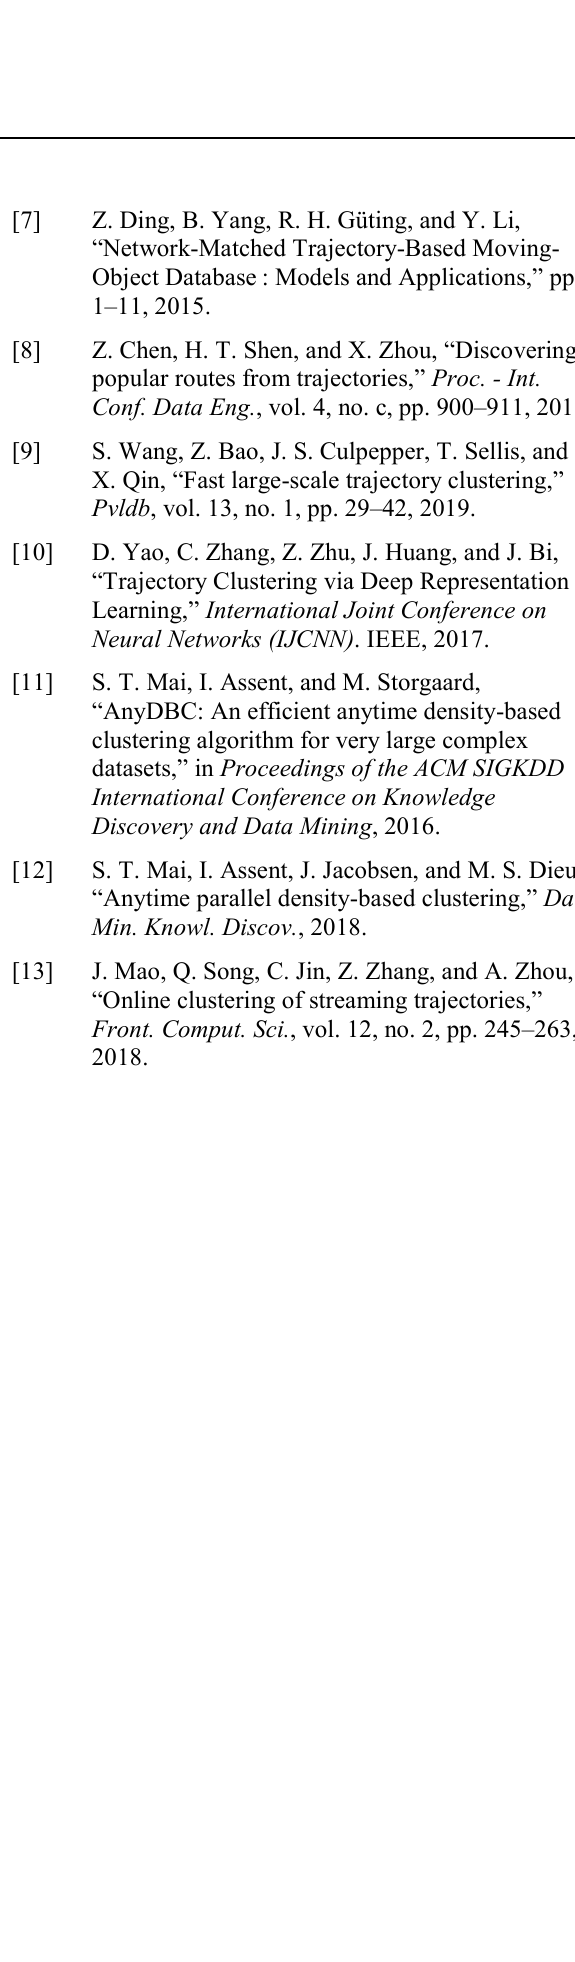
Fig.10. Clustering based on velocity features from Ho Chi Minh City Dataset: each cluster contains mixing types of